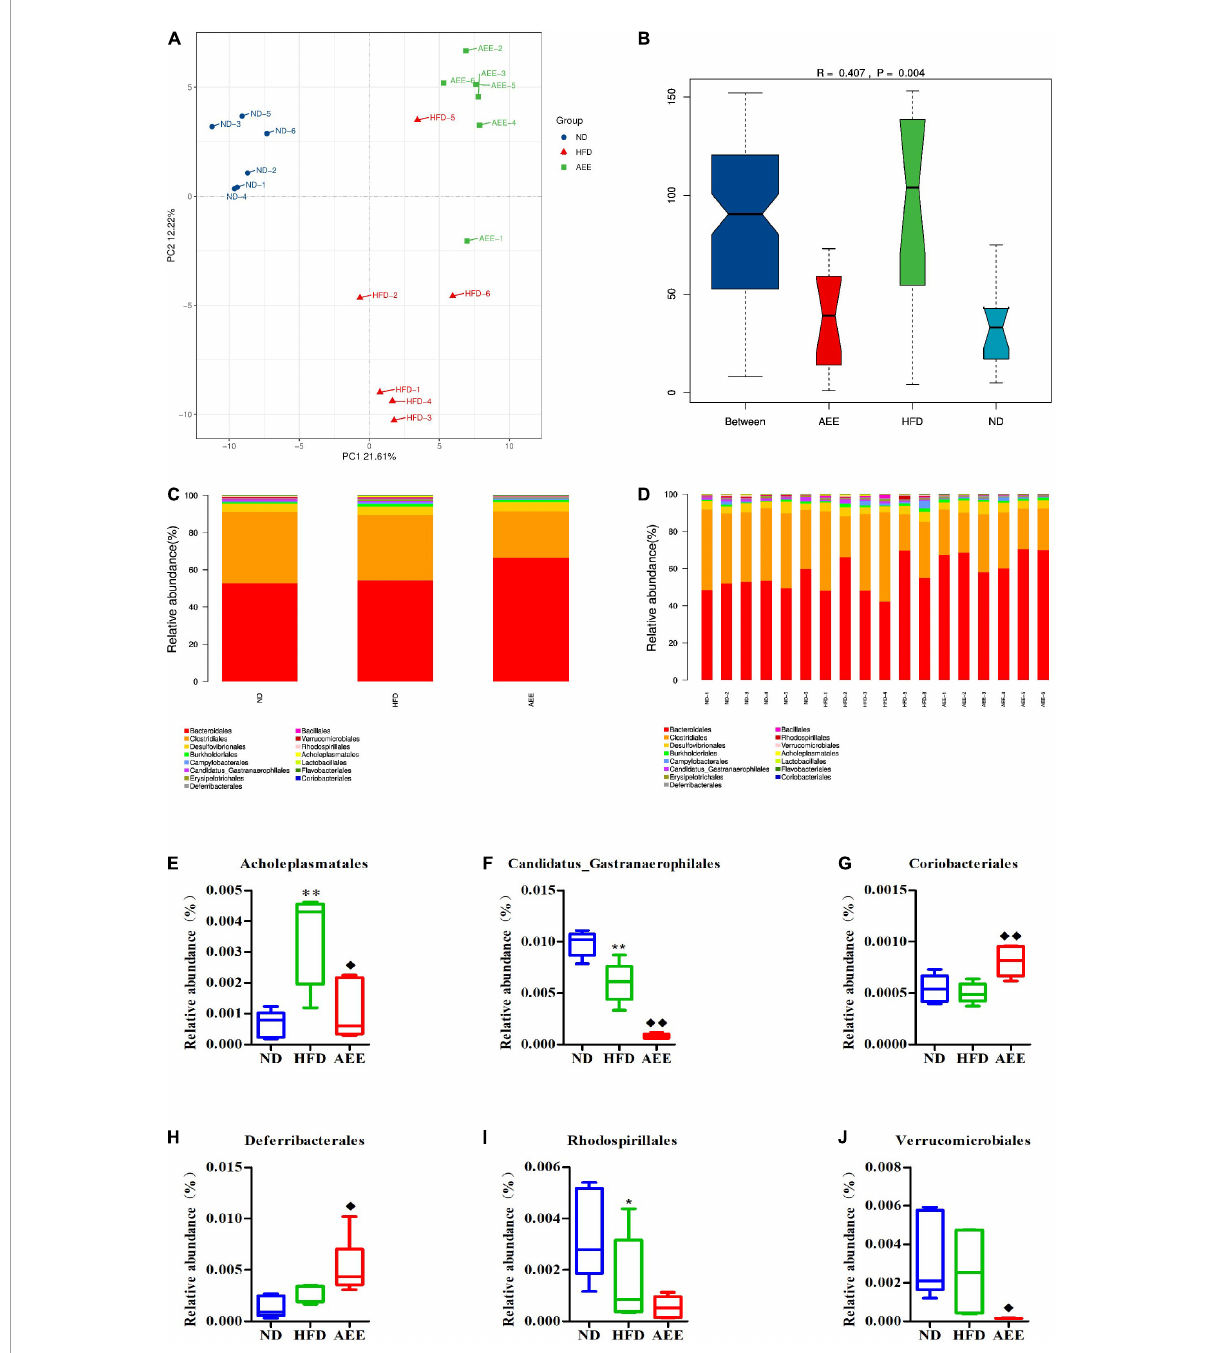
FIGURE7 Microbiota compositions at the Order level. (A) PCA results of the similarities in bacterial community structures at the Order levels. (B) Analysis of Anosim based on Order level. (C,D) Histogram of relative abundance at the Order level. (E–J) Relative content of Acholeplasmatales, Candidatus_Gastranaerophilales, Coriobacteriales, Deferribacterales, Rhodospirillales, and Verrucomicrobiales at the Order level. Values are presented as mean ± SD ( n = 6). Differences were assessed by ANOVA and denoted as follows: ∗∗ P < 0.01, ∗ P < 0.05 compared with the ND group; (cid:117)(cid:117) P < 0.01, (cid:117) P < 0.05 compared with the HFD